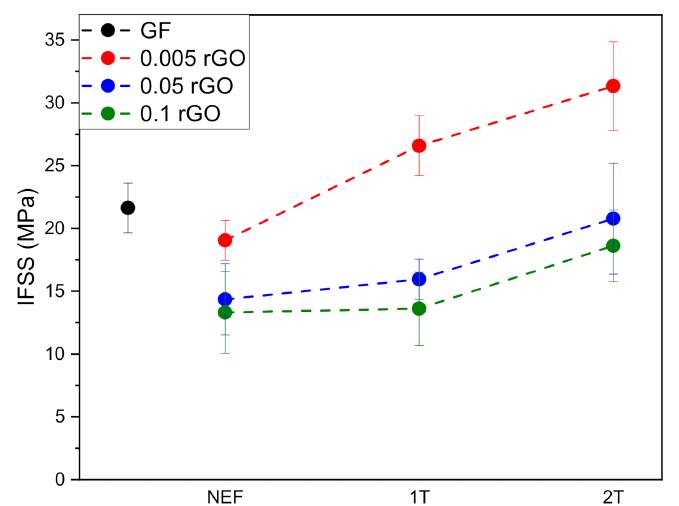
Figure 9. Comparison of interfacial shear strength (IFSS) values obtained from micro debonding tests on uncoated and rGO coated